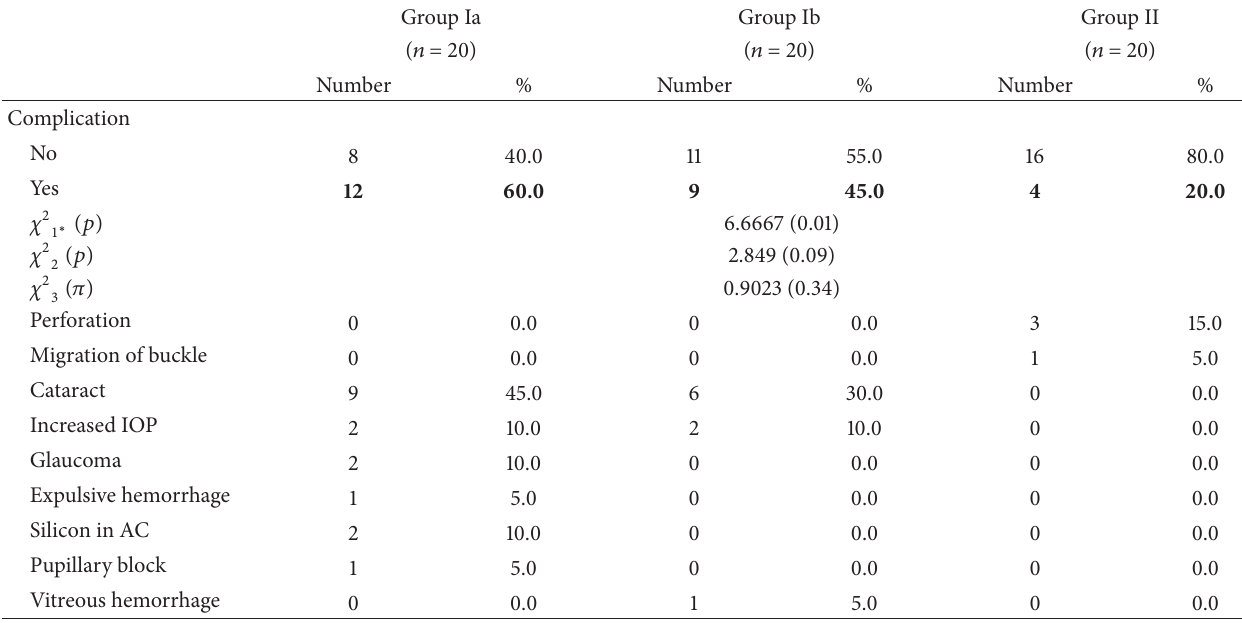
Table 2: Complications occurring in each group during the study